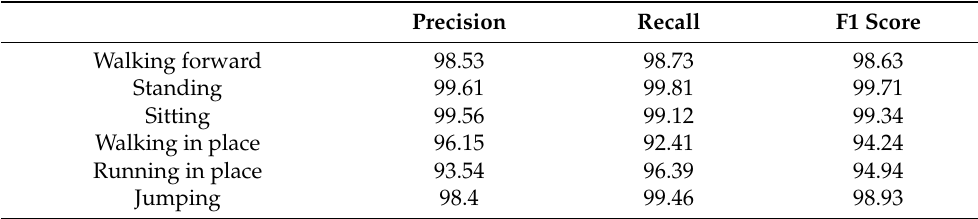
Table 6. The recognition precision, recall, and F1 score for various activities in the W-HAR dataset (%). Precision Recall Walking